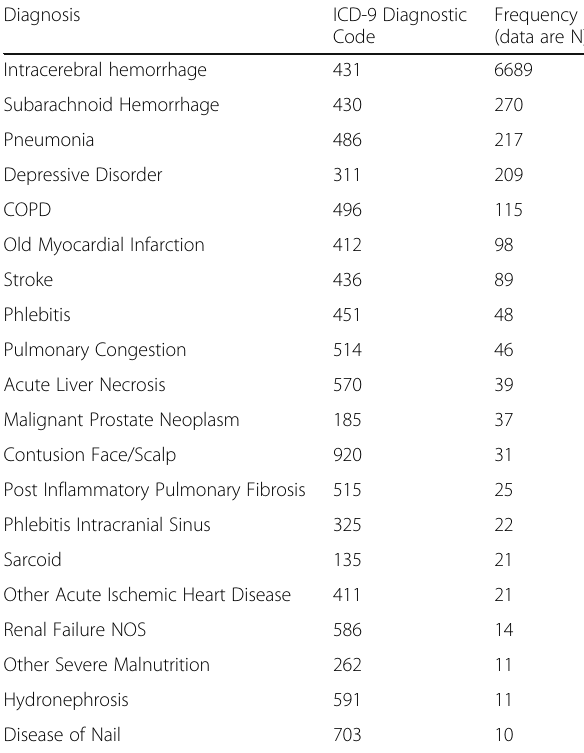
Table 2 Frequency of Diagnostic Codes in the Multicenter Cohort